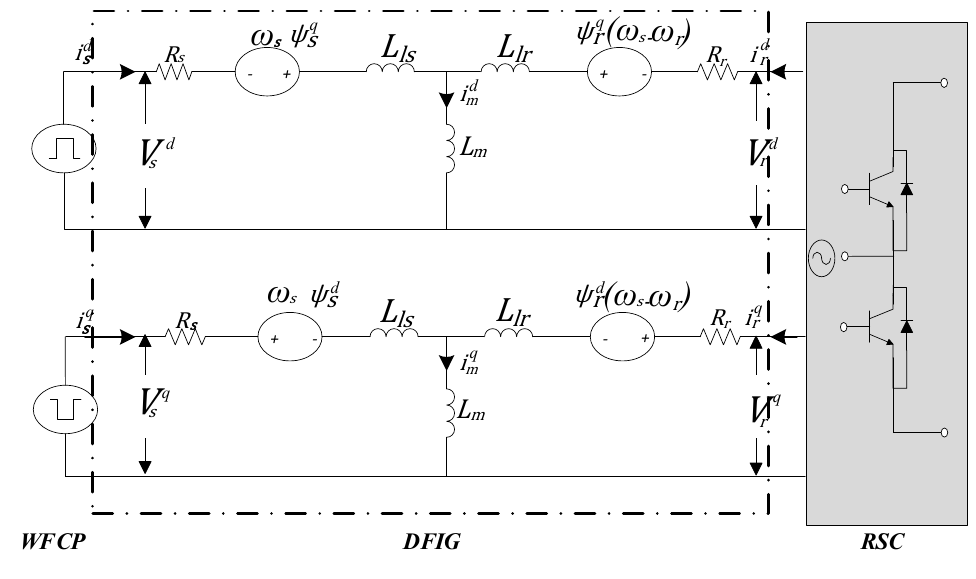
Figure 2. Equivalent circuit of DFIG.